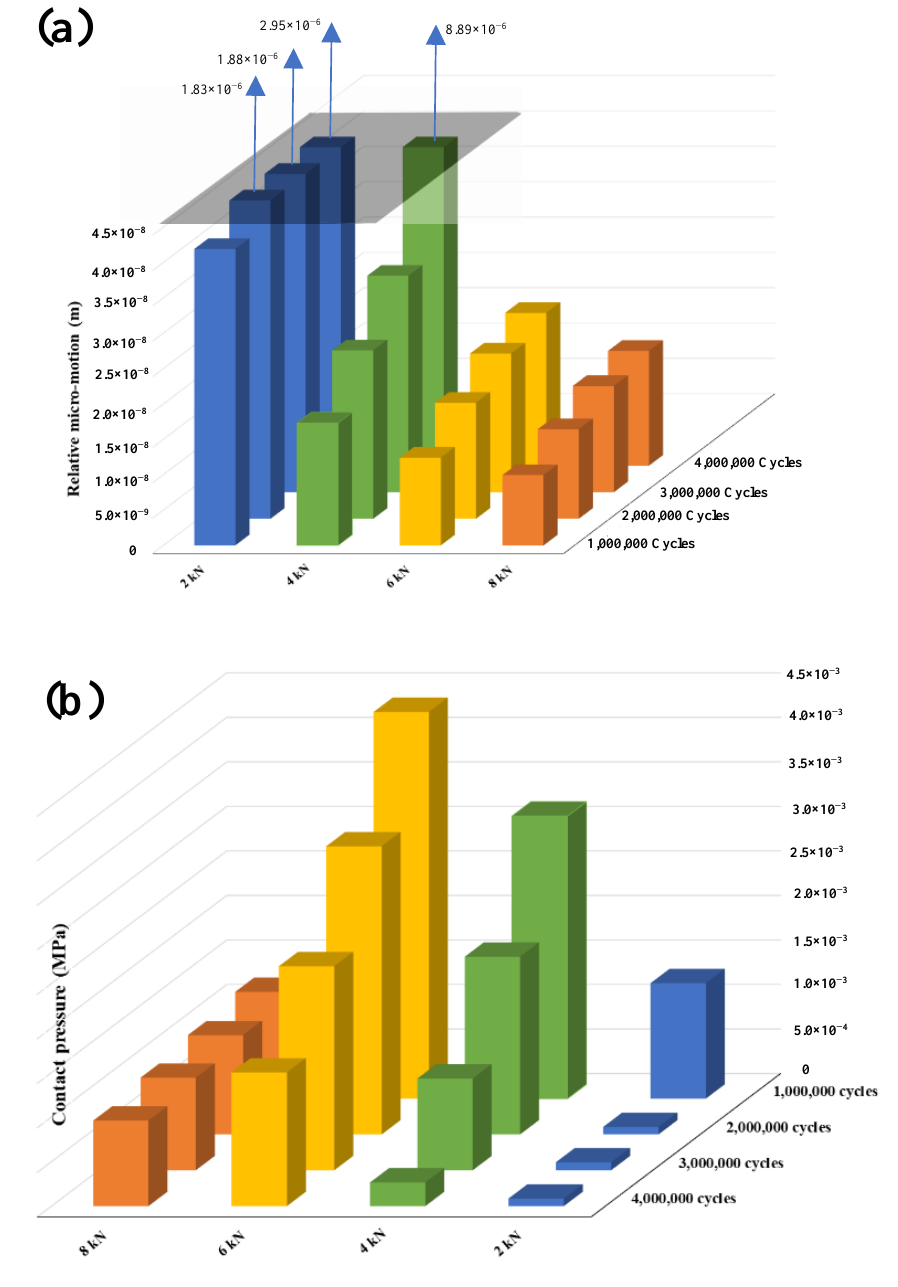
Figure 9. Variation of the: ( a ) Micromotion; ( b ) Pressure, at the neck contact surface.